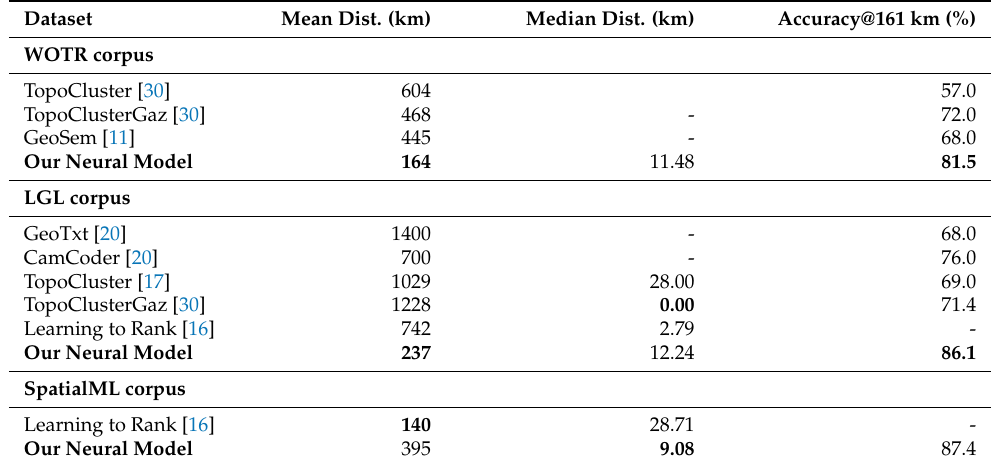
Table 2. Experimental results obtained with the base ELMo models, without using Wikipedia data to complement the training instances, or the information on geophysical terrain